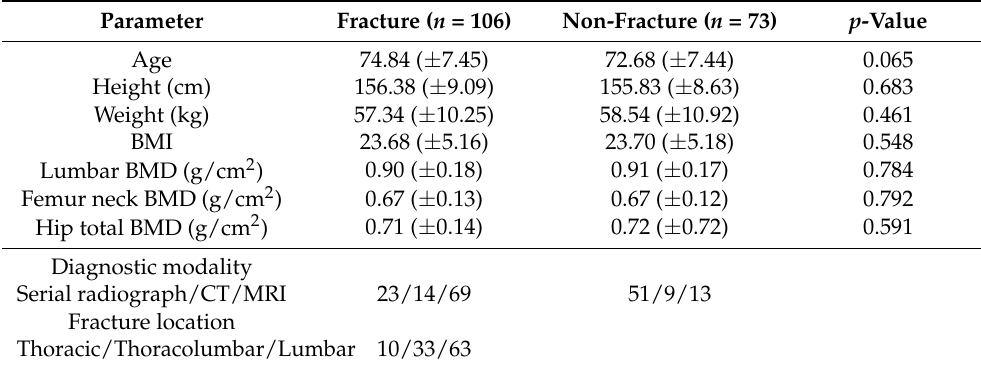
Table 1. Demographic data of fracture and non-fracture